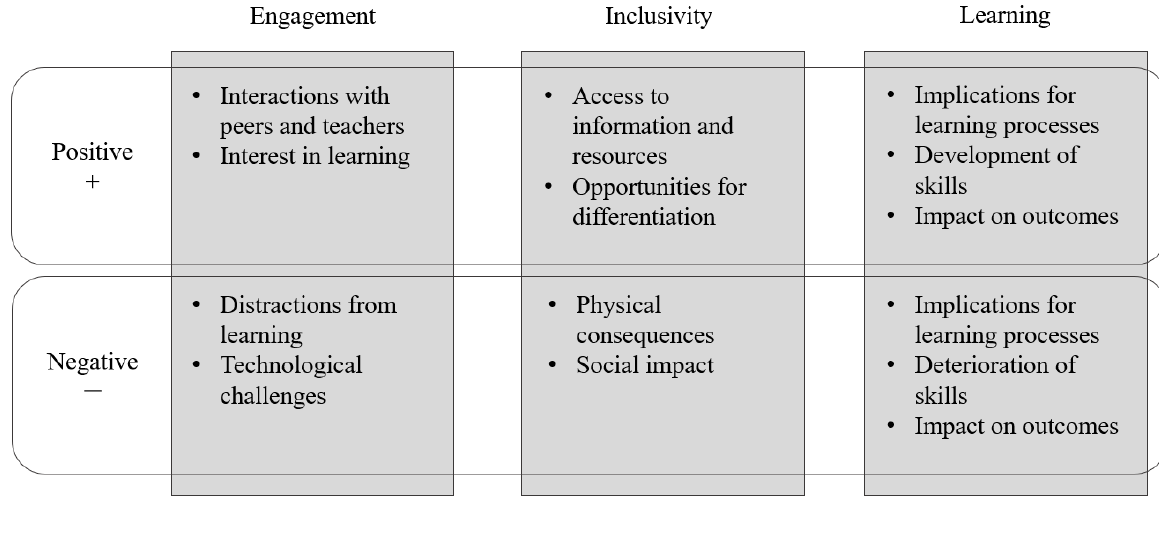
Summary of Themes Organized by Positive and Negative Perceptions